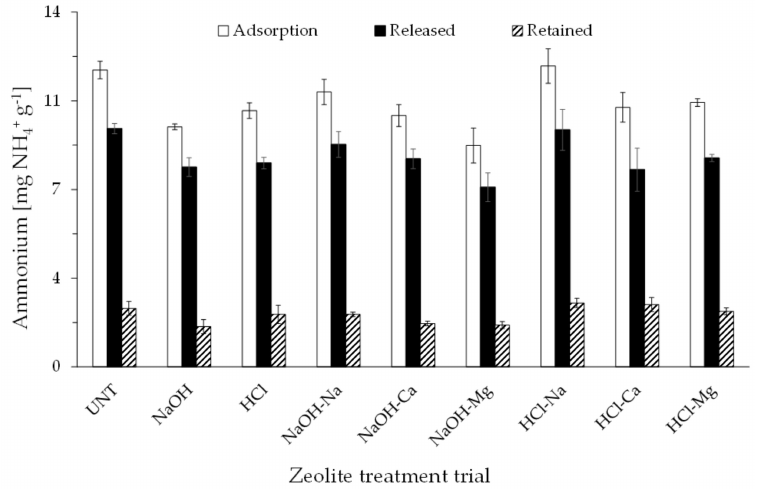
Figure 13. Amount of ammonium adsorbed, released and retained by treated clinoptilolite. Treatments are untreated clinoptilolite (UNT), pre-treated clinoptilolite with 1 M sodium hydroxide (NaOH) or 0.1 M hydrochloric acid (HCl), and treated clinoptilolite with sodium chloride (NaCl), calcium chloride (CaCl 2 ) magnesium chloride (MgCl 2 ) after each pre-treatment (NaOH-Na, NaOH-Ca, NaOH-Mg, HCl-Na, HCl-Ca, HCl-Mg). Values are means of three replicates, and bars are standard